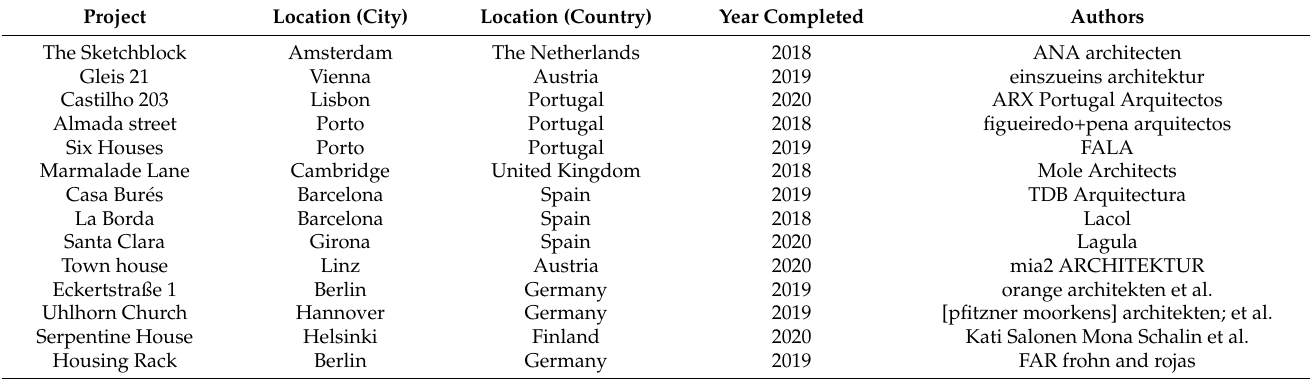
Table 2. Selected